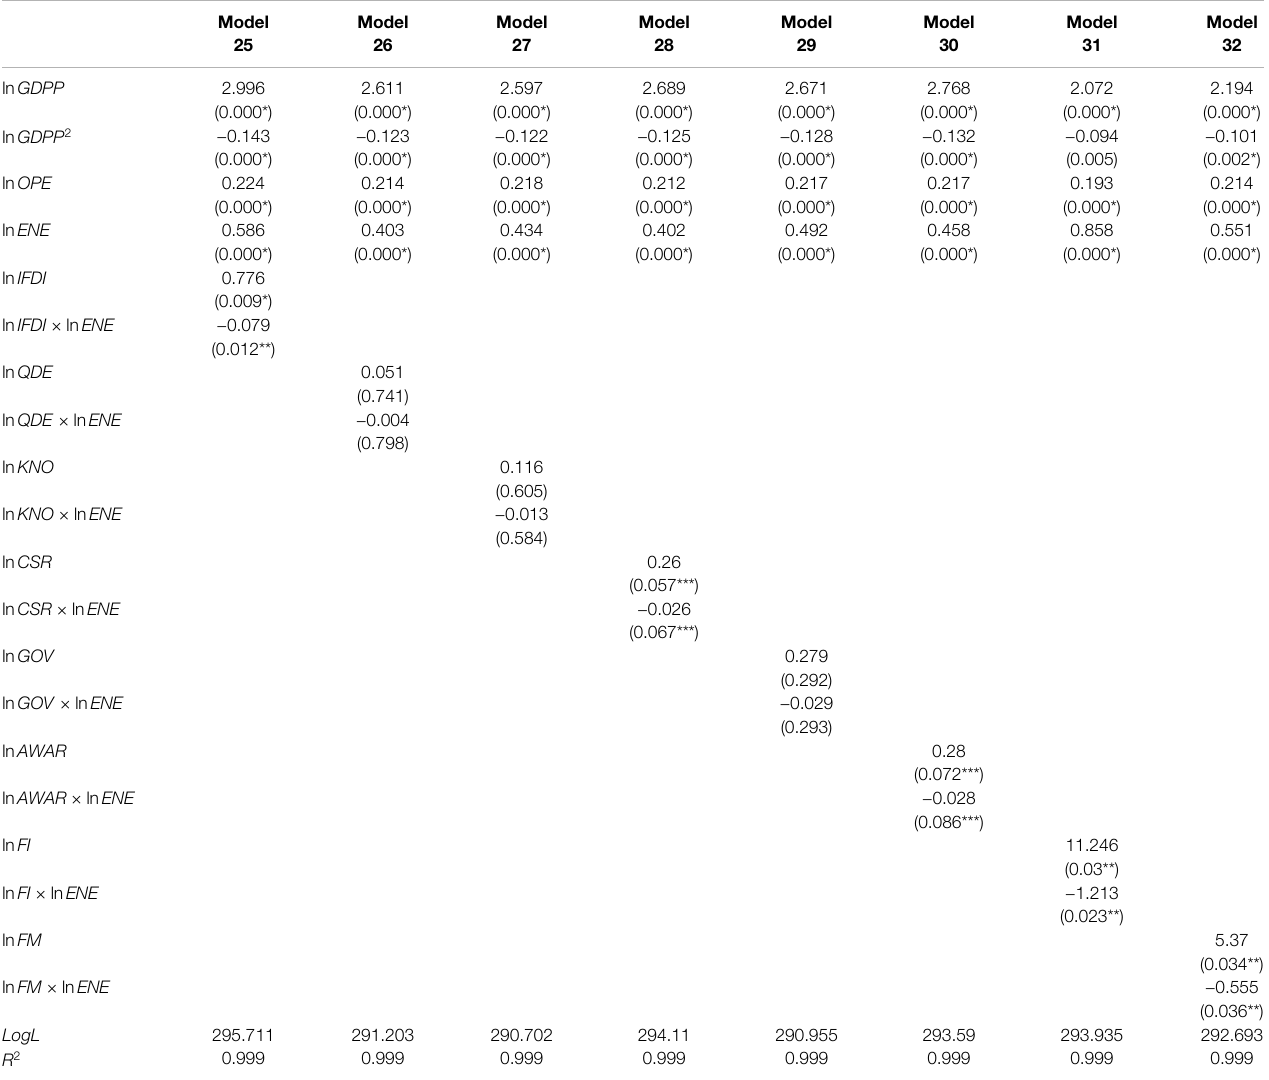
TABLE 9 | Estimation results of different models for Eq. 7